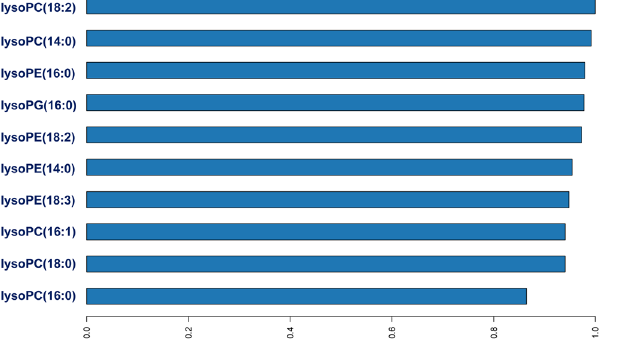
Figure 4. Variable importance plot of the optimal deep learning model. Top three predictors are lysoPC(18:2), lysoPC(14:0), and